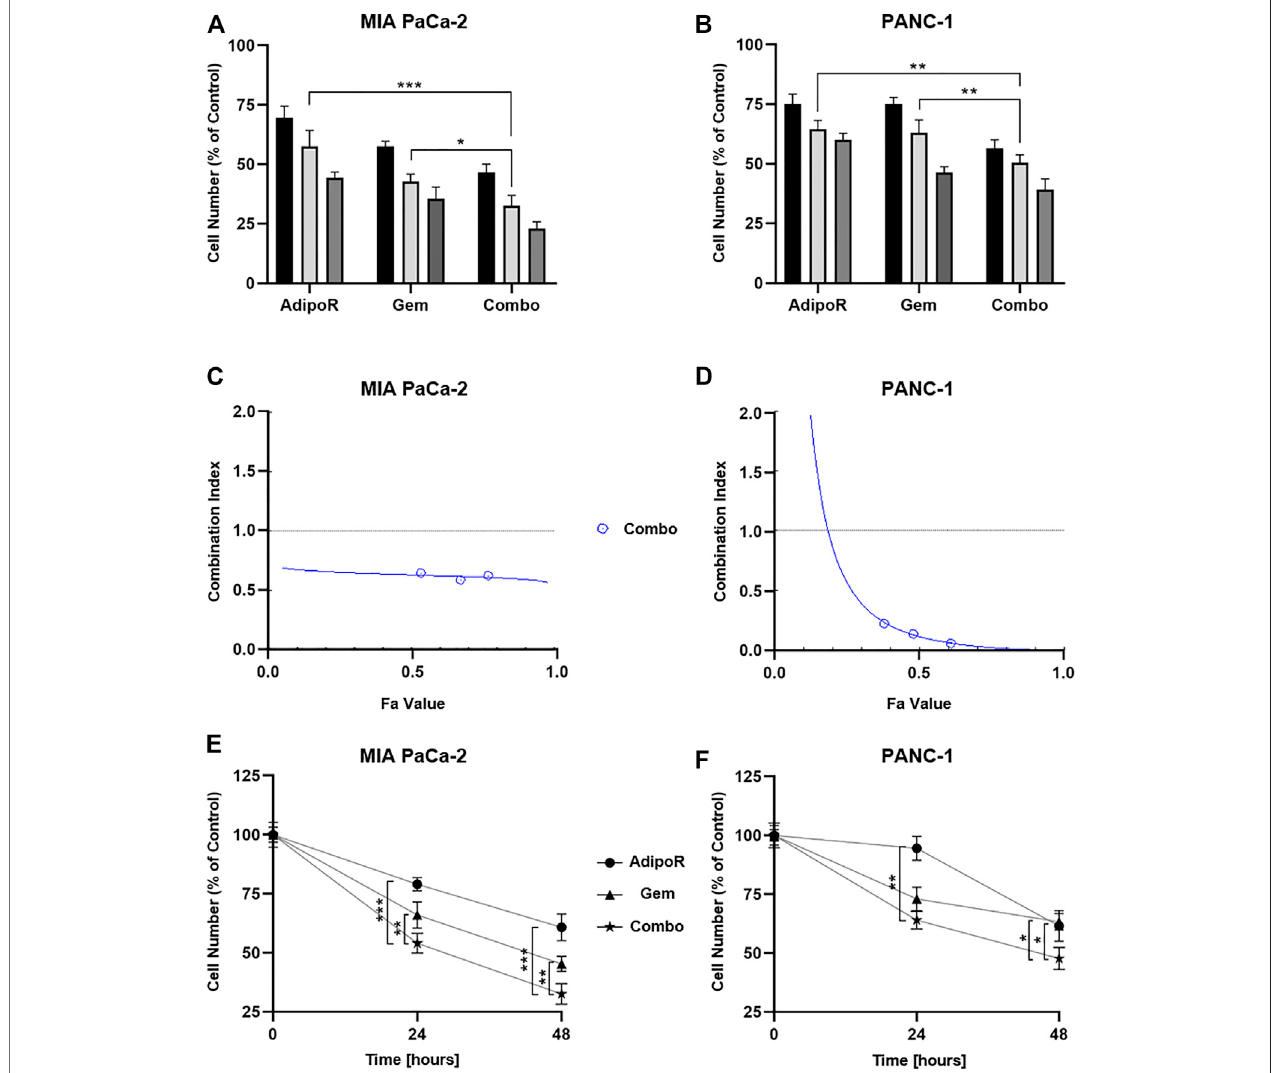
FIGURE 2 | Assessment of single and combinatory outcomes in PDAC cells. (A) 5 (black bar), 10 (light gray), and 20 µg/ml (gray) of AdipoR were added to MIA PaCa-2 cell medium for 48 h, either alone or in combination with 7.5 (black bar), 15(light gray), and 30 nM (gray) Gem. Colors ofthe columns re fl ect those ofsingle drug concentrations in combination setting. (B) Identical AdipoR amounts were instead mixed with 25 (black bar), 50 (light gray), and 100 nM (gray) Gem in PANC-1. Representative Fa-CI report obtained in MIA PaCa-2 (C) and PANC-1 (D) . (E) MIA PaCa-2 growth curves achieved after 24 and 48 h under 10 µg/ml AdipoR, 15 nM Gem, and AdipoR plus Gem, respectively. The same AdipoR concentration (10 µg/ml) and a different Gem amount (50 nM) were applied in PANC-1 time course experiments (F) . For each stimulation, cell number was estimated at least in triplicate and reported in fi gure as average ± SD in % of control. * p < 0.05, ** p < 0.01, *** p < 0.001 by Tukey ’ s multiple comparisons